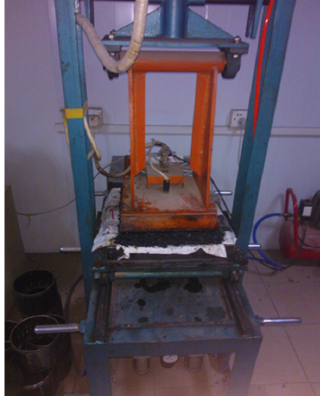
Figure 1. Rut sample manufactured by wheel rolling.